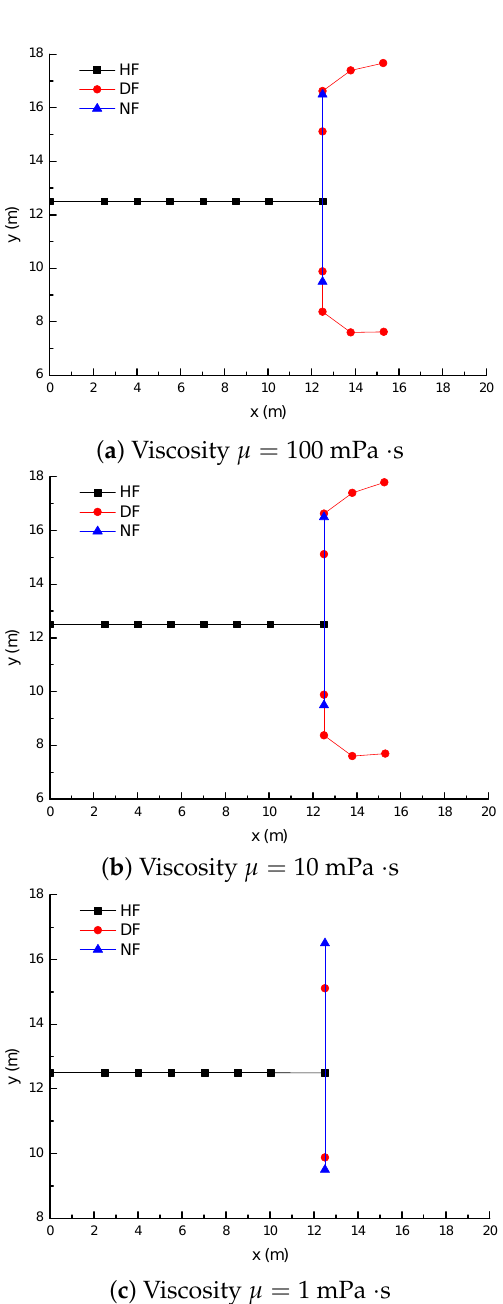
Figure 20. The crack propagation paths at different levels of viscosity of fracturing fluid. The Von-Mises stress distributions at different levels of fluid viscosity are shown in Figure